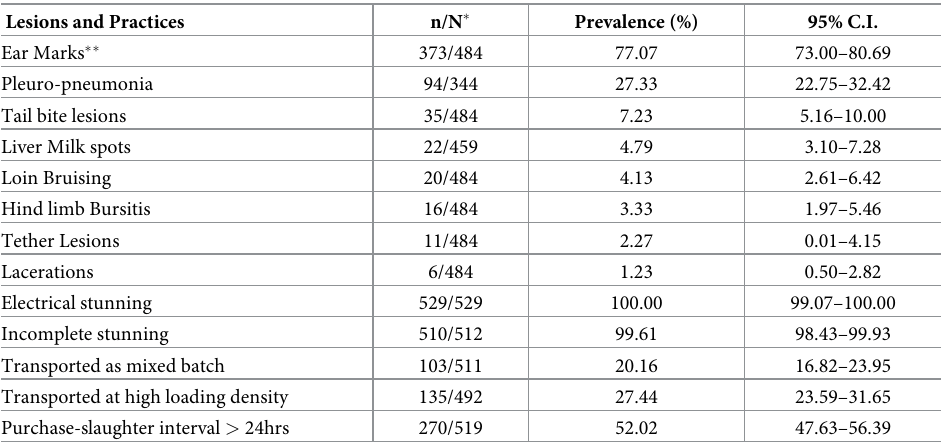
Table 4. Summary of gross lesions and practices